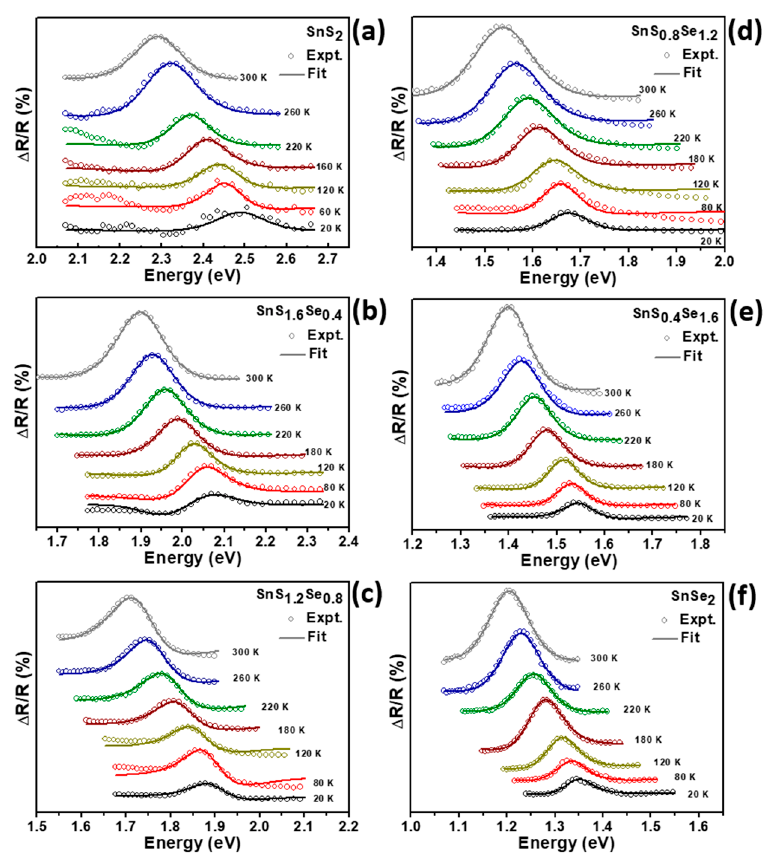
Figure 5. ( a – f ) Experimental PzR spectra at various temperatures of the SnS 2-x Se x layered crystals for S content x ranging from 0 to 2. The solid curves are the least-squares fits to Equation (1).